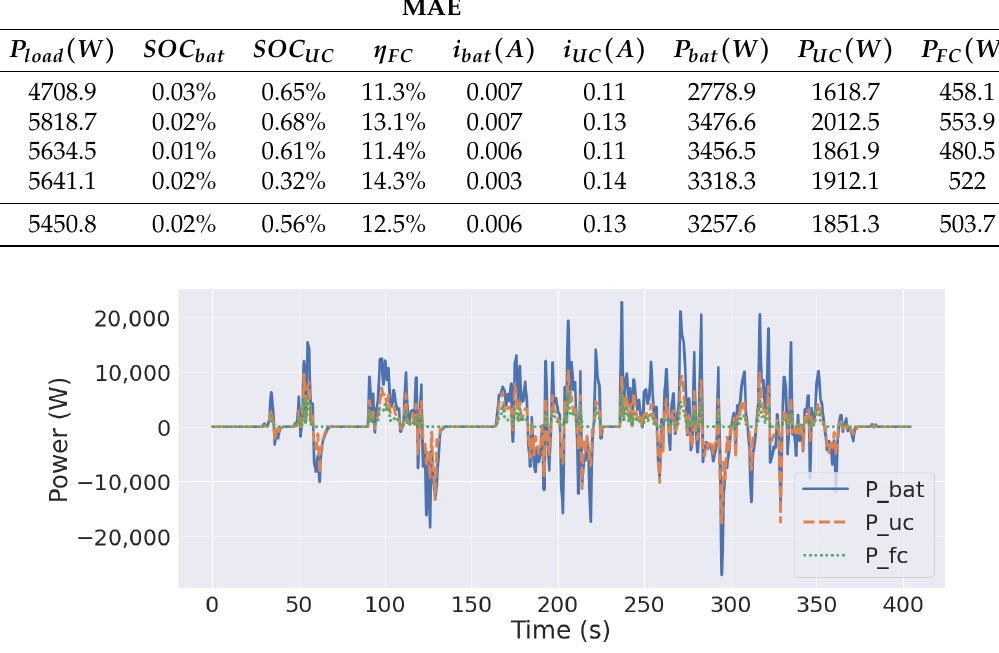
Figure 16. Predicted battery, ultracapacitor and fuel cell powers by